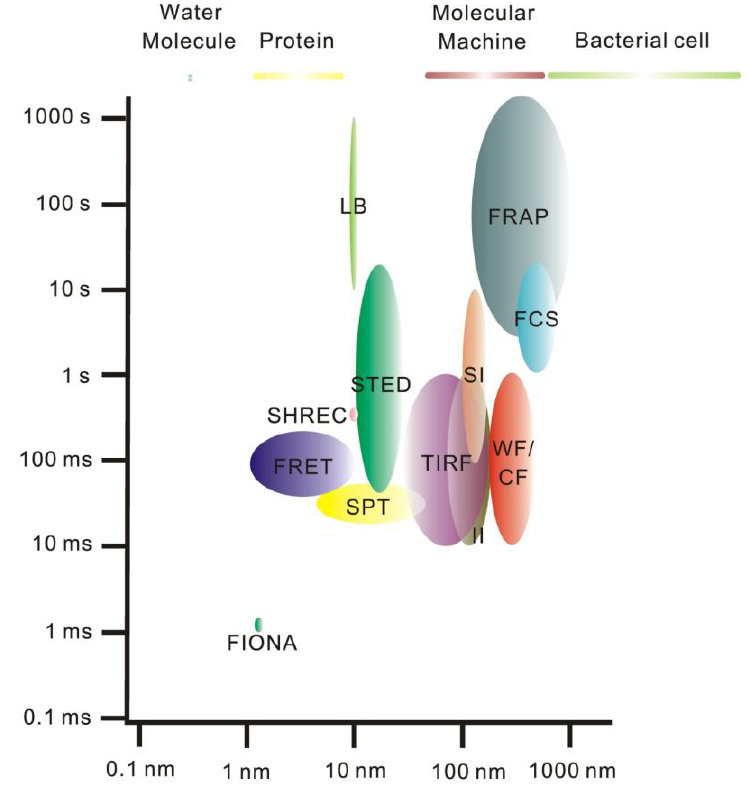
Figure 2. Comparison of the spatial and temporal resolutions of fluorescence microscopy. The length and time scales are logarithmic. Average sizes of some biological features are given (top panel). For FIONA, II, LB, SHREC, SI, SPT, STED, TIRF, and WF/CF, the horizontal dark side of each oval approximates the x - y -resolution/localization accuracy and the bright side approximates the z -resolution/localization accuracy. For example, TIRF and WF/CF have similar x - y -resolution, but TIRF has a much better z -resolution. For FRET the horizontal scale represents distance over which molecular interaction can be detected. For FCS and FRAP the horizontal scale represents the limiting size of the measurement field. The vertical scales refer to the amount of time needed to take one image frame or complete one measurement, the reciprocal of which represents the maximum rate at which dynamic changes in the sample can be detected. FCS, fluorescence correlation spectroscopy; FIONA, fluorescence imaging with one nanometer accuracy; FRAP, fluorescence recovery after photobleaching; FRET, Förster resonance energy transfer; II, interference illumination; LB, localization-based; SHREC, single-molecule high-resolution co-localization; SI, structured-illumination; SPT, single particle tracking; STED, stimulated emission depletion; TIRF, total internal reflection fluorescence; WF/CF, wide-field/confocal. Based on